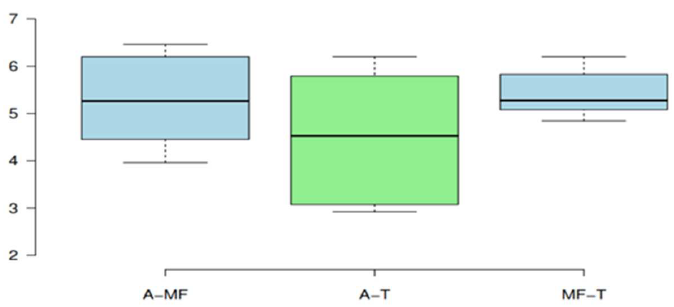
Figure 5. Box plot for RMSE in two-parameter subset performance.